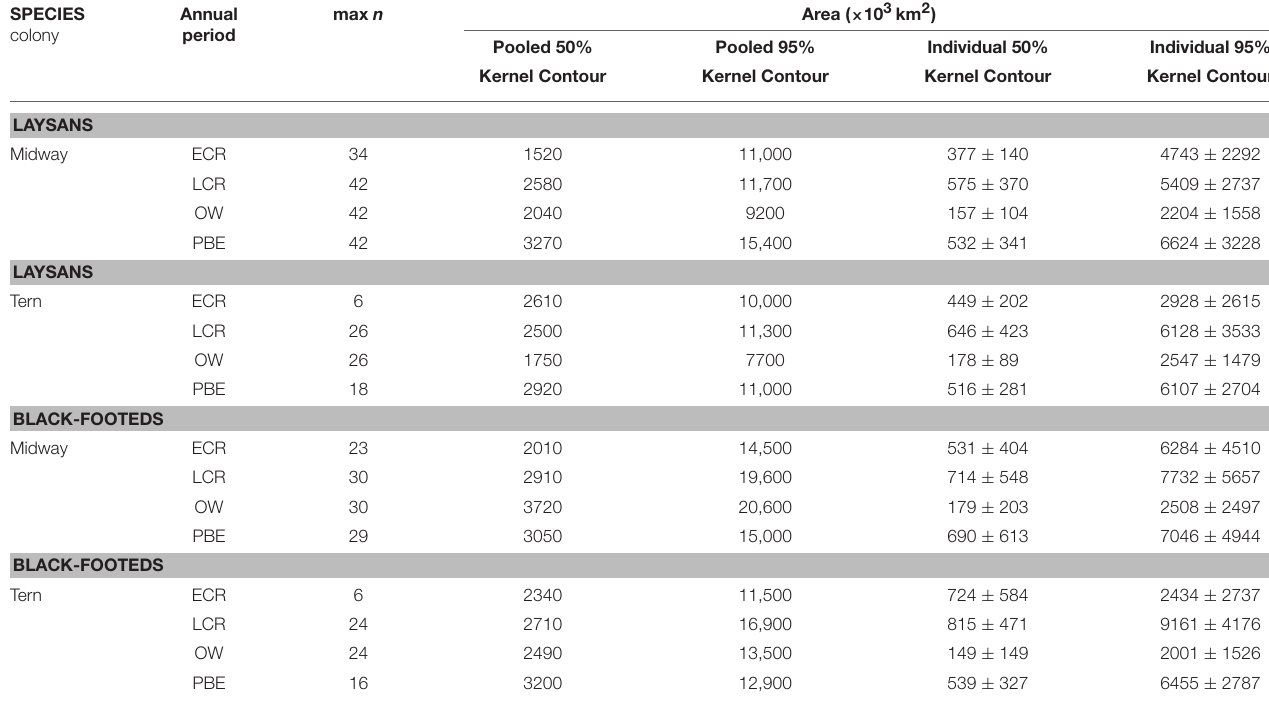
TABLE 2 | Kernel contour areas from pooled and individual KDE